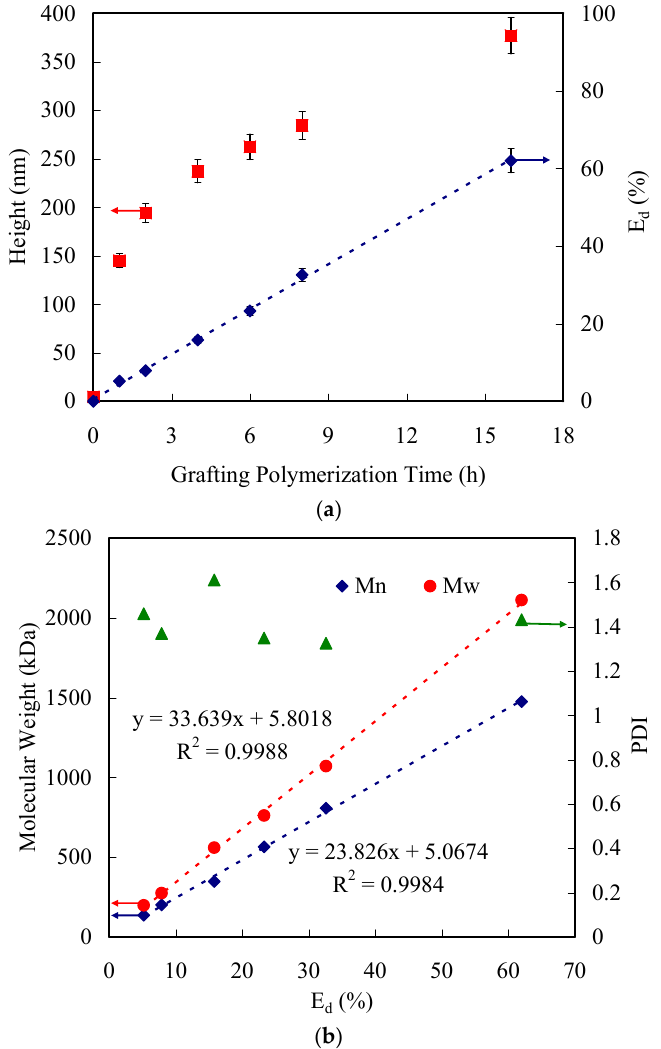
Figure 7. ( a ) Heights and E d values of DG-PMAA for TM polarization at m = 0 versus grafting polymerization time. ( b ) Dependence of molecular weights including Mn and Mw of PMAA brushes on E d values with PDI.